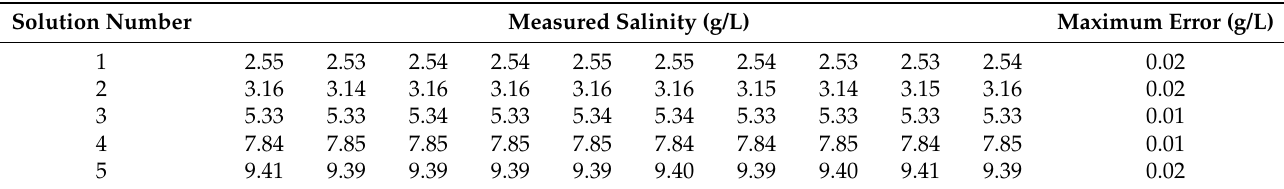
Table 6. Repeatability of the test data.